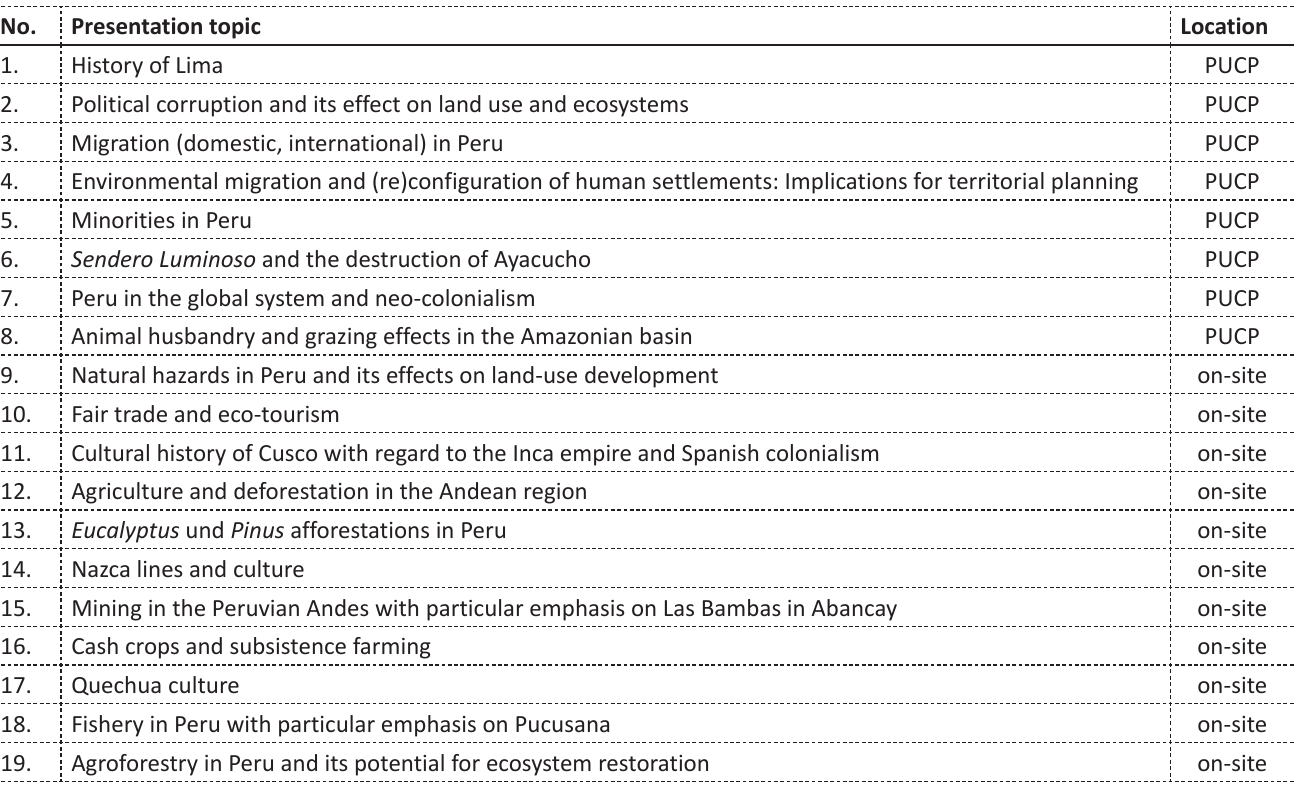
Animal husbandry and grazing effects in the Amazonian